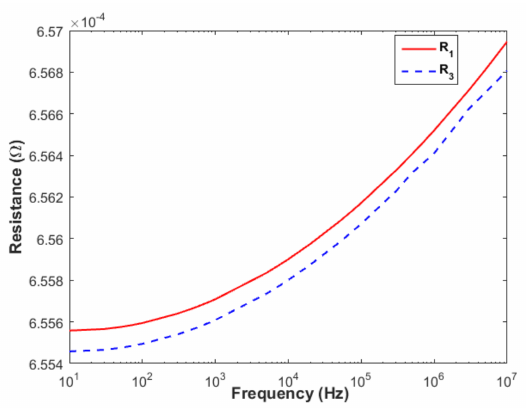
Figure 7. The frequency-dependent resistances of the transformer winding, R1 and